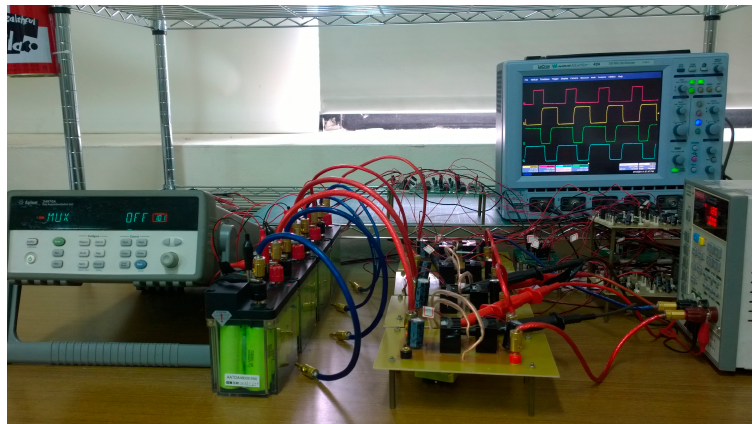
Figure 7. The laboratory circuit of the battery power bank.